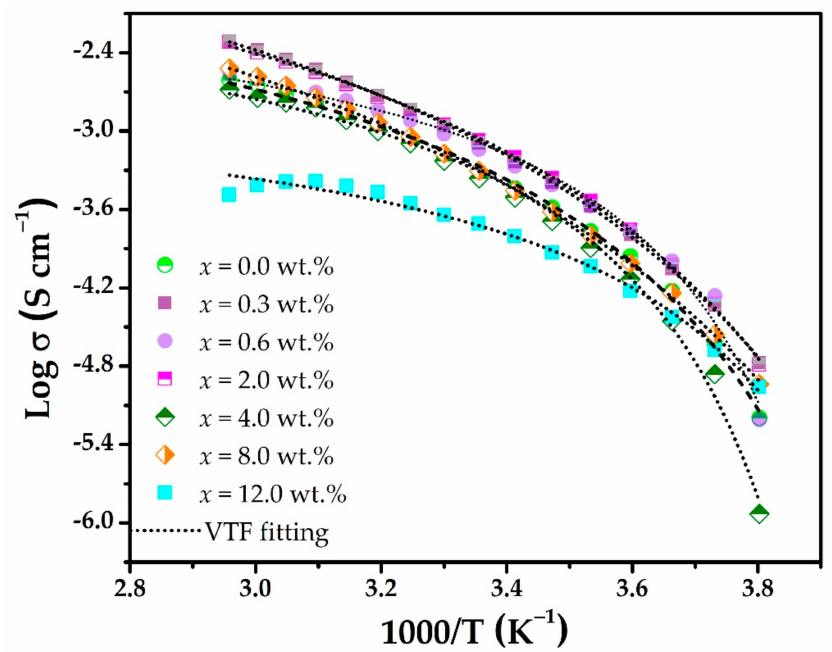
Figure 8. Logarithm of the conductivity as a function of the inverse of temperature for (PEO) 4 CF 3 COOLi + x % MWCNT